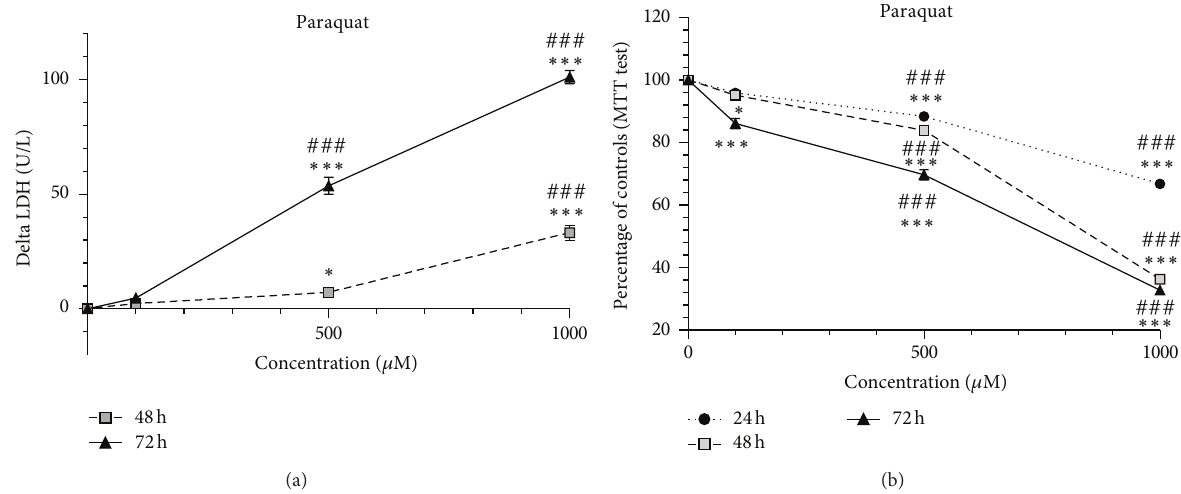
Figure 1: PQ toxicity occurred in a concentration- and time-dependent manner in differentiated SH-SY5Y cells. Cells were incubated with 100, 500 and 1000 𝜇 M of PQ for 24, 48 and 72 h. (a) Increase in LDH release into the medium in differentiated SH-SY5Y cells. The delta increase in LDH release in units per liter (U/L) into the medium was calculated by subtraction of the respective controls (results were pooled from 3 different experiments, each experiment having 6 different culture wells per condition). (b) Mitochondrial dysfunction in differentiated SH-SY5Y cells evaluated by the MTT test. The viability of untreated control cells was set to 100%, and all treatments were expressed as the percentage of the respective controls (results were pooled from 3 different experiments, each experiment having 6 different culture wells per condition). The means were compared using the two-way ANOVA test, followed by the Bonferroni post hoc test ( ∗ 𝑃 < 0.05 , ∗∗∗ 𝑃 < 0.001 concentration versus control; ### 𝑃 < 0.001 concentration versus